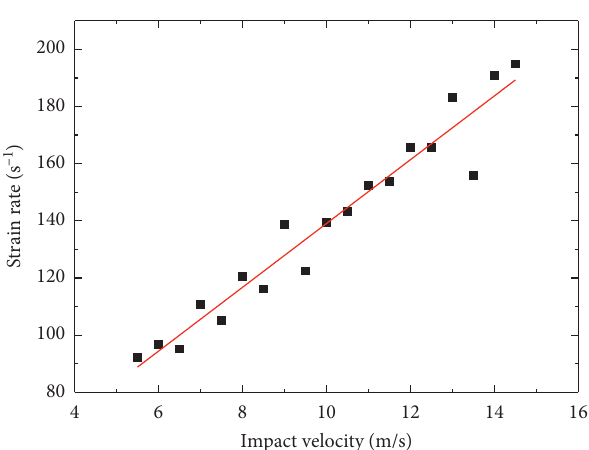
Figure 10: Impact velocity-strain